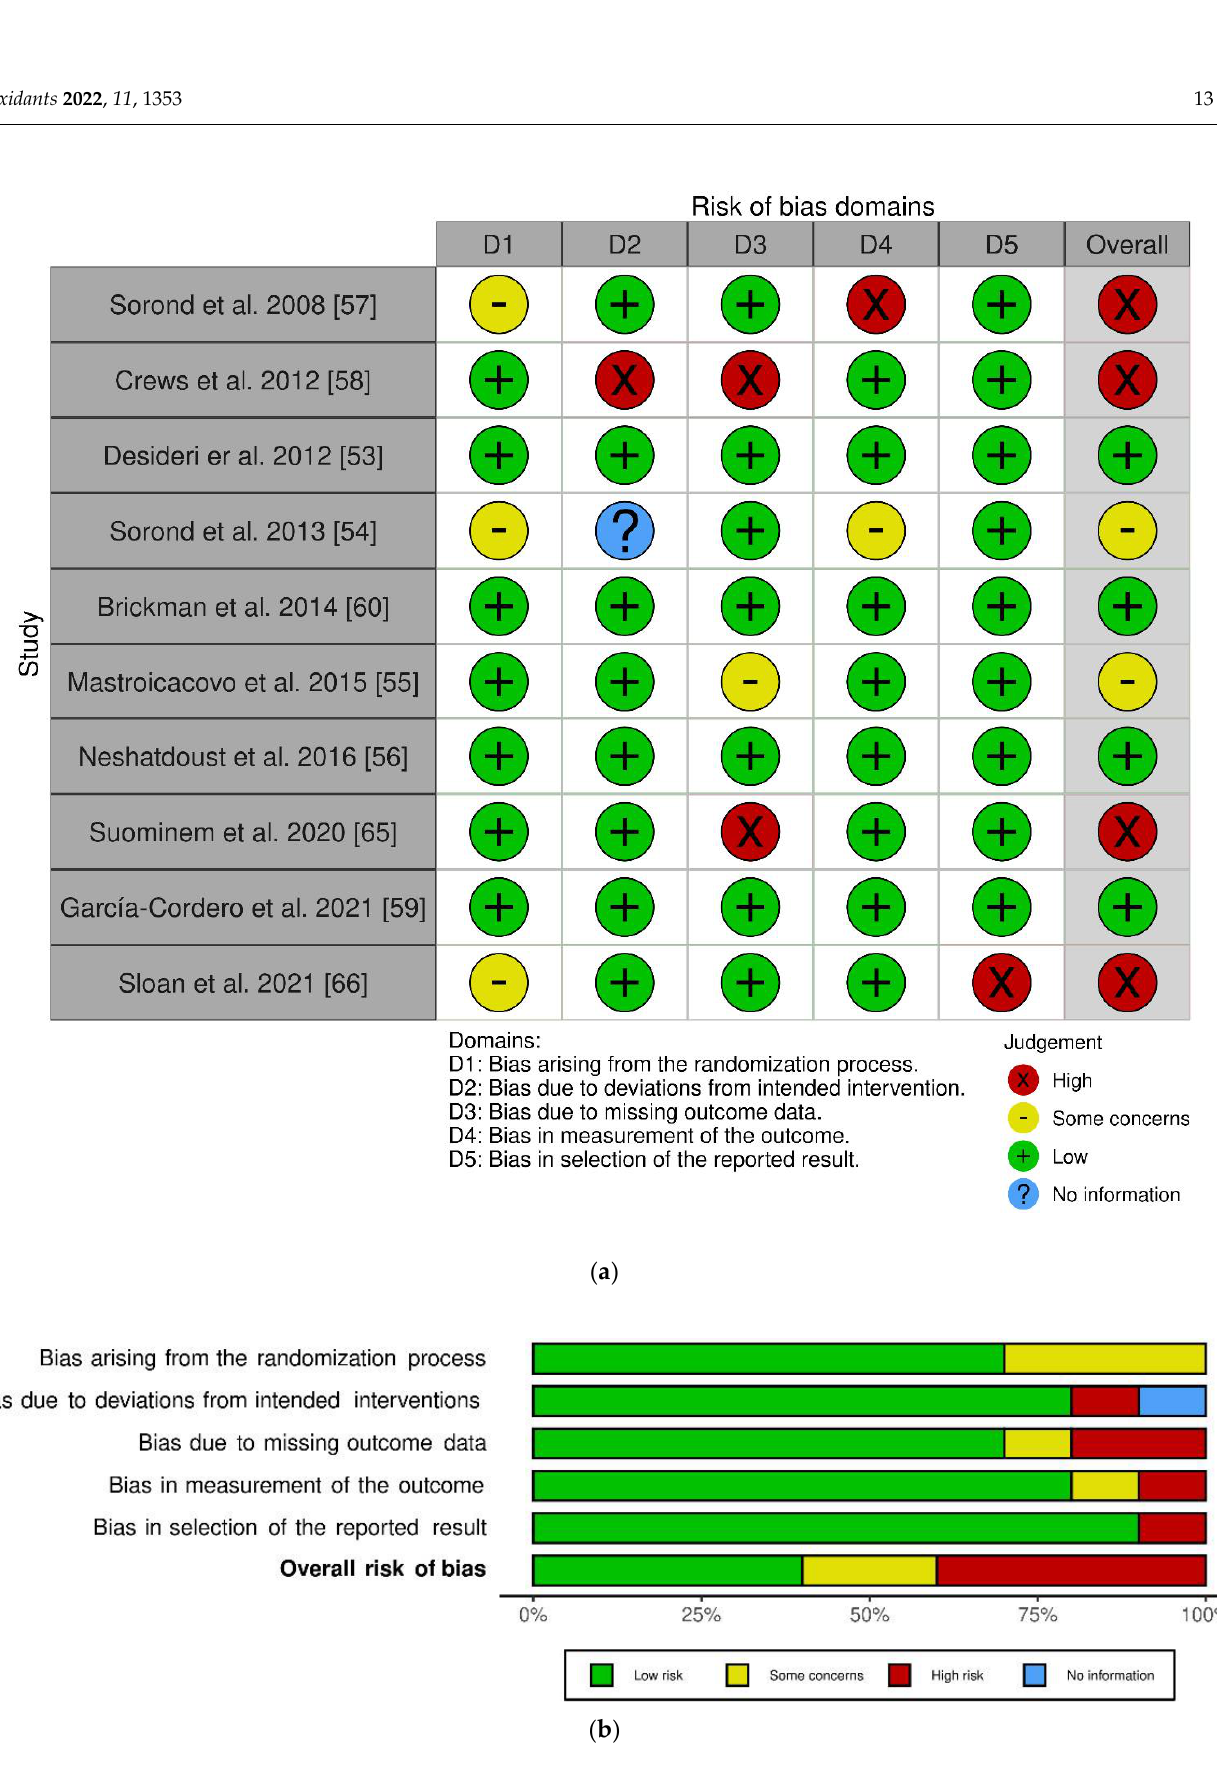
Figure 2. Risk of bias using Cochrane Risk of Bias tool for randomized clinical trials (RoB2) [69]: Individual studies assessment, ( a ); overall assessment, ( b ).